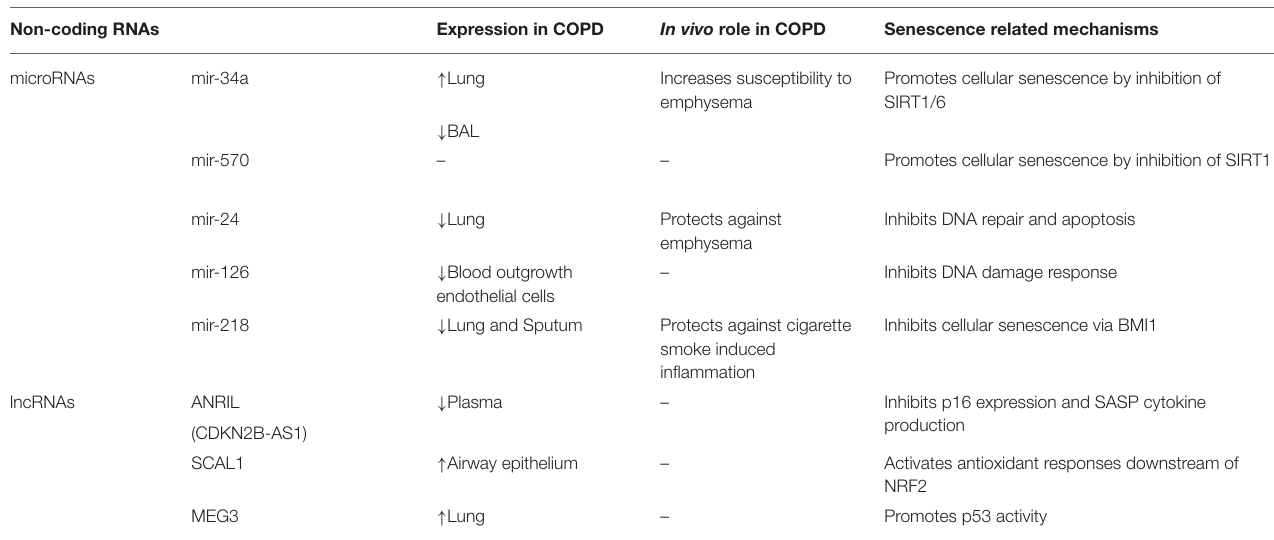
TABLE 2 | Aging related non-coding RNAs in